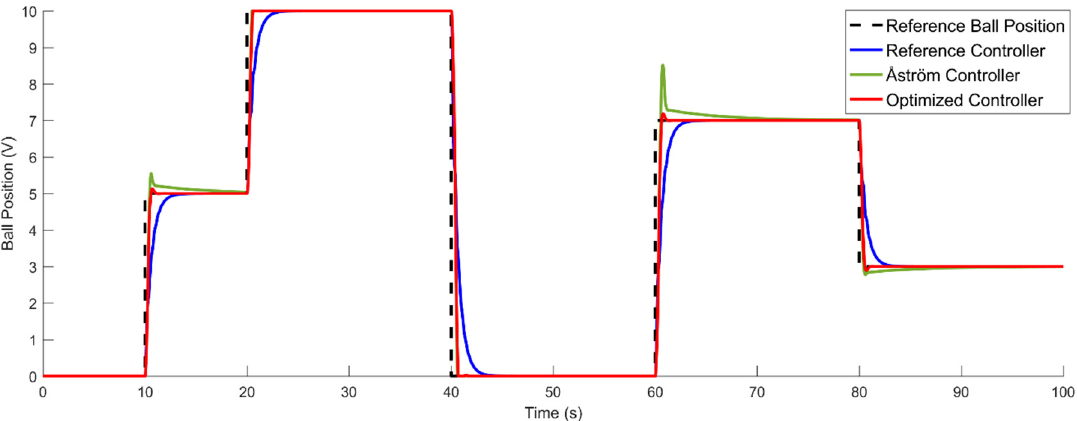
Figure 15. System response to reference changes for the different controllers.